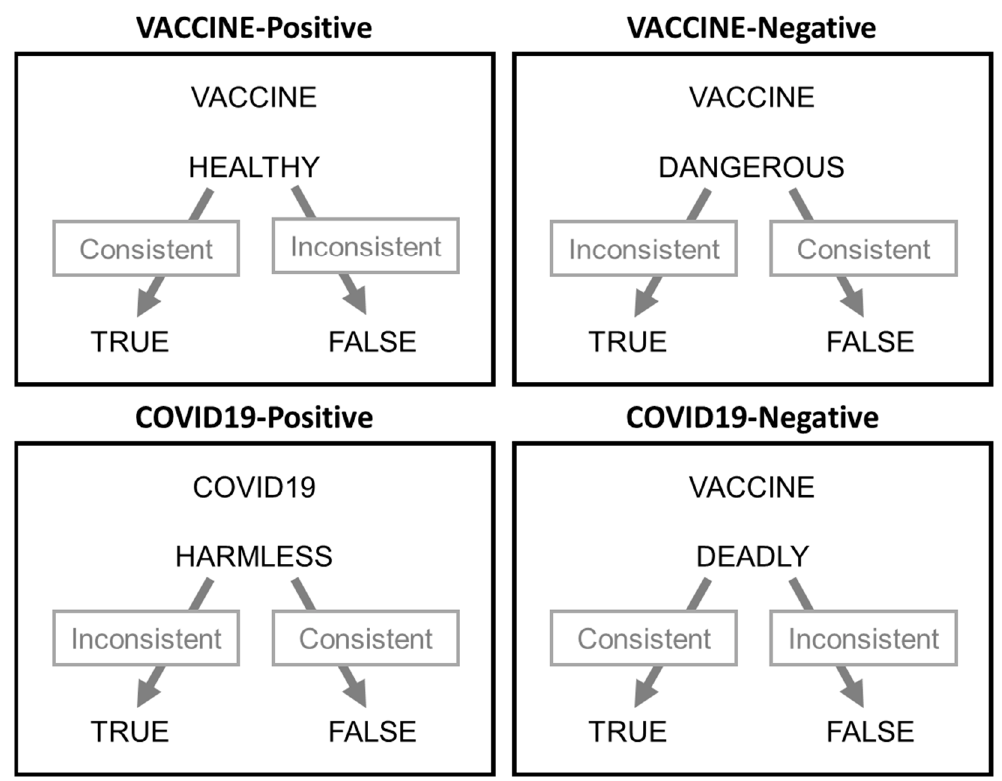
Figure 1. The four trial types as a combination of labels (VACCINE and COVID-19) and targets (positive or negative adjectives). The response options are shown at the bottom. Grey boxes and arrows were not presented and indicate which responses are correct in consistent or inconsistent blocks.